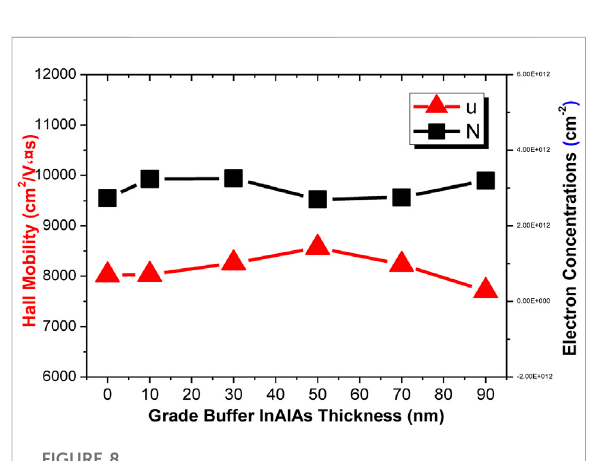
FIGURE 8 The 2-deg properties of different In x Al 1-x As graded buffer layers with In 0.66 Ga 0.34 As channel.